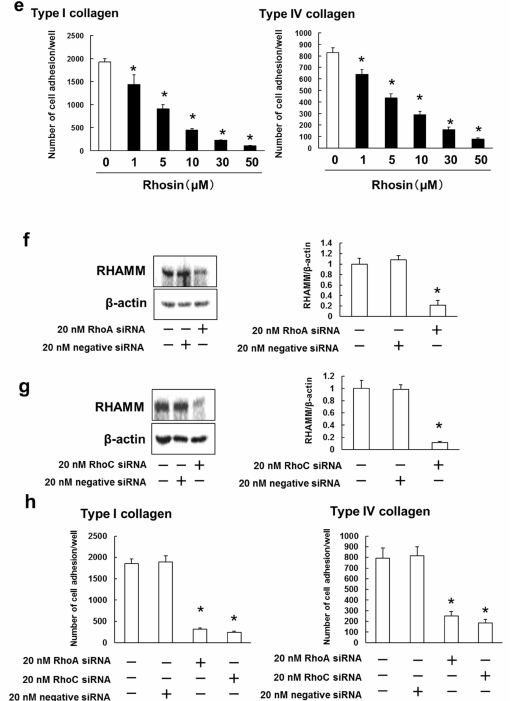
Figure 4. High metastatic potential cell lines of B16BL6 cells enhanced expression of RHAMM, CD44 and CXCR4: ( a ) Images of Western blots for the RHAMM, CD44, CXCR4, CCR7 and β - actin (internal standard), and quantification of the amounts of RHAMM, CD44, CXCR4 and CCR7 after normalization to the amounts of corresponding protein. The results are representative of 4 independent experiments. * p < 0.01 vs. B16F1 cells (ANOVA with Dunnett’s test); ( b ) B16BL6 cells were treated with rhosin at indicated concentration for 3 days. Images of Western blots for the RHAMM, CD44 and β -actin (internal standard), and quantification of the amounts of RHAMM and CD44 after normalization to the amounts of corresponding protein. The results are representative of 4 independent experiments. * p < 0.01 vs. controls (ANOVA with Dunnett’s test); ( c ) B16BL6 cells (1 × 10 4 cells), which had been treated with rhosin for 3 days, were incubated with type I collagen- or type IV collagen-coated plates for 30 min at 37 ◦ C in an atmosphere containing 5% CO 2 . The results are representative of 5 independent experiments. * p < 0.01, as compared to the controls (0.1% DMSO-treated) (ANOVA with Dunnett’s test); ( d ) 4T1 cells were treated with rhosin at indicated concentration for 3 days. Images of Western blots for the RHAMM, CD44 and β -actin (internal standard), and quantification of the amounts of RHAMM and CD44 after normalization to the amounts of corresponding protein. The results are representative of 4 independent experiments. * p < 0.01 vs. controls (ANOVA with Dunnett’s test); ( e ) 4T1 cells (1 × 10 4 cells), which had been treated with rhosin for 3 days, were incubated with type I collagen- or type IV collagen-coated plates for 30 min at 37 ◦ C in an atmosphere containing 5% CO 2 . The results are representative of 5 independent experiments. * p < 0.01, as compared to the controls (0.1% DMSO-treated) (ANOVA with Dunnett’s test); ( f , g ) B16BL6 cells were treated with negative siRNA, ( f ) RhoA siRNA, or ( g ) RhoC siRNA at indicated concentration for 3 days. Images of Western blots for the RHAMM and β -actin (internal standard), and quantification of the amounts of RHAMM after normalization to the amounts of β -actin. The results are representative of 4 independent experiments. * p < 0.01 vs. controls (ANOVA with Dunnett’s test); ( h ) B16BL6 cells (1 × 10 4 cells), which had been treated with negative siRNA, RhoA siRNA, or RhoC siRNA for 3 days, were incubated with type I collagen- or type IV collagen-coated plates for 30 min at 37 ◦ C in an atmosphere containing 5% CO 2 . The results are representative of 5 independent experiments. * p < 0.01, as compared to the controls (0.1% DMSO- treated) (ANOVA with Dunnett’s